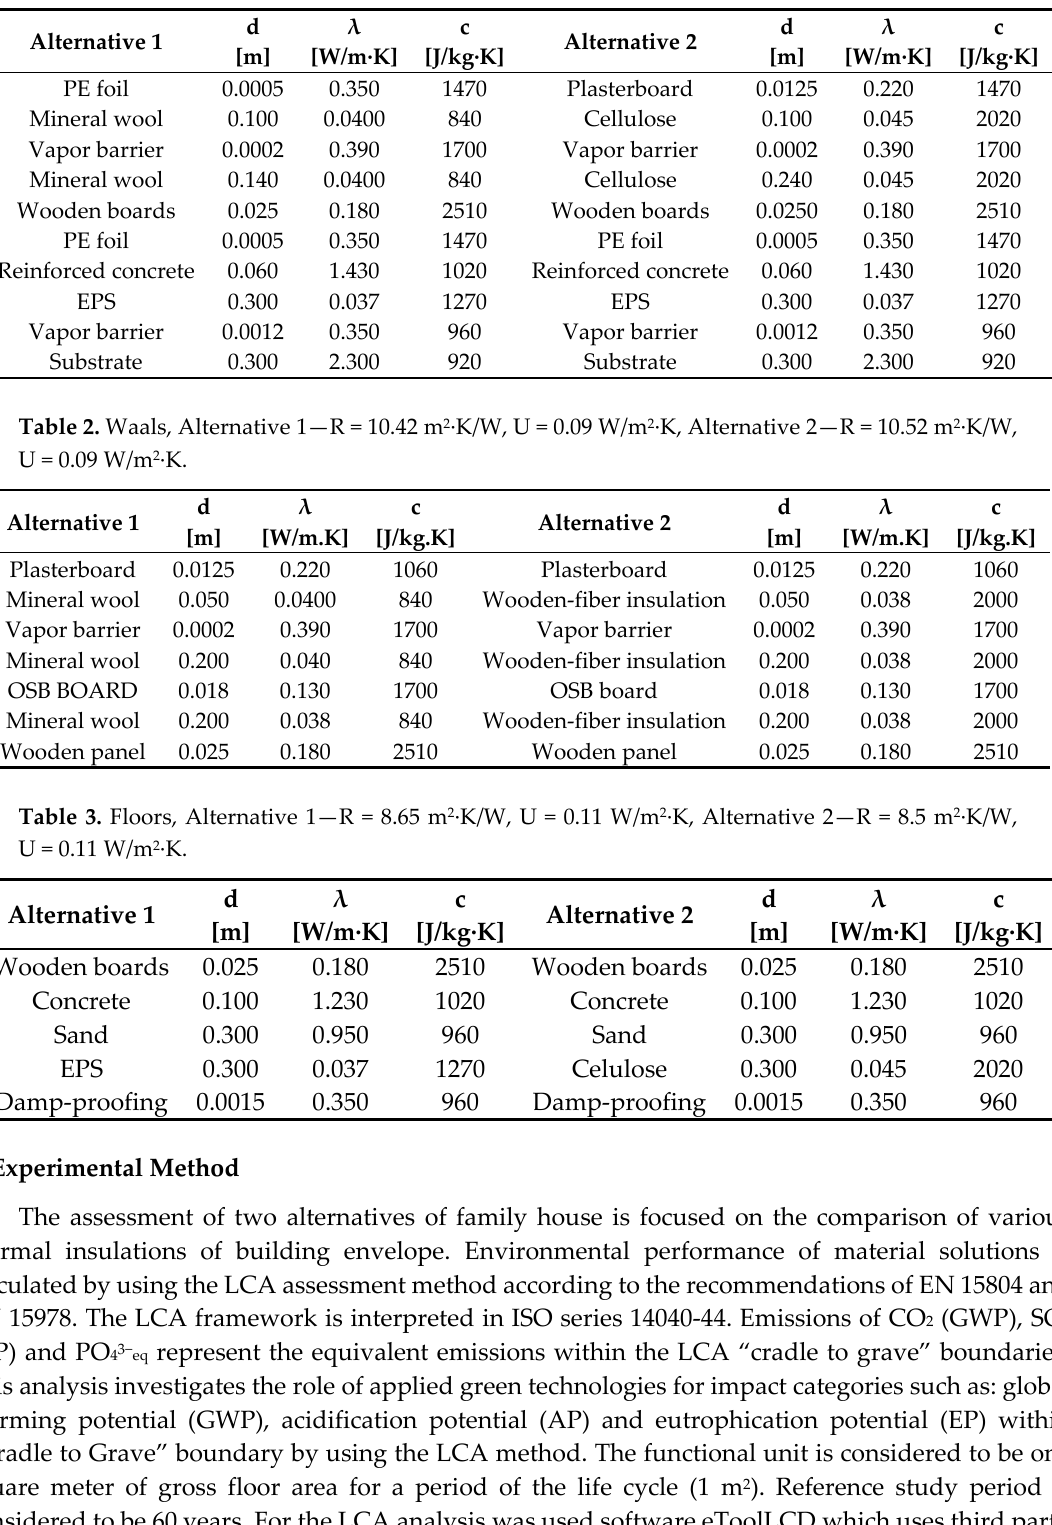
Table 1. Roofs, Alternative 1—R = 9.28 m 2 ·K/W, U = 0.11 W/m 2 ·K, Alternative 2—R = 9.2 m 2 ·K/W, U = 0.11 W/m 2 ·K.